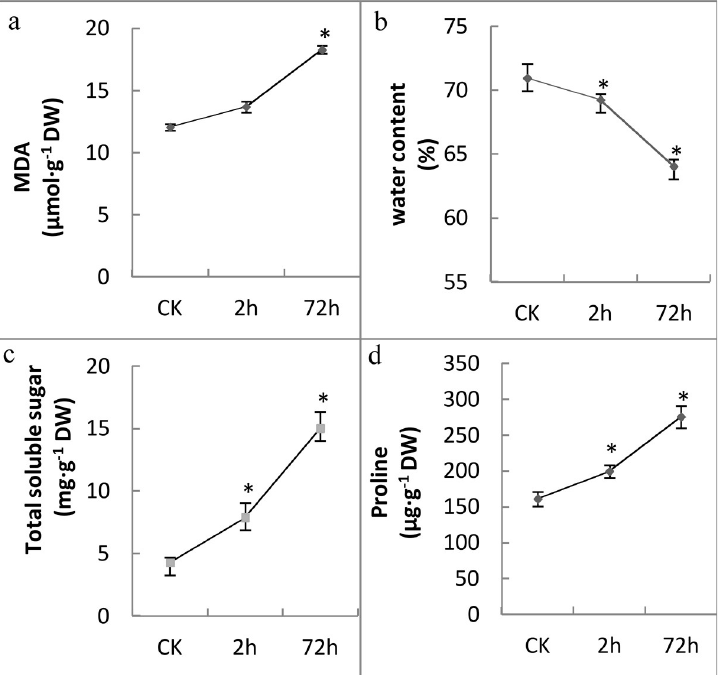
Fig 7. Physiological changes in leaves under cold stress. Error bars indicate SE ( n = 5 biological replicates, � P < 0.05).